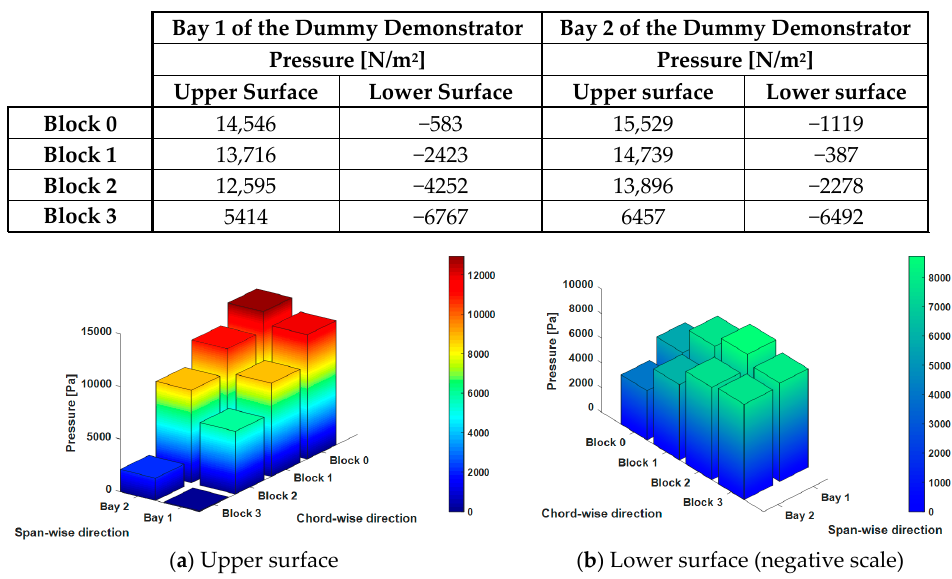
Figure 8. Pressure distribution values along the trailing edge and relative colormaps.